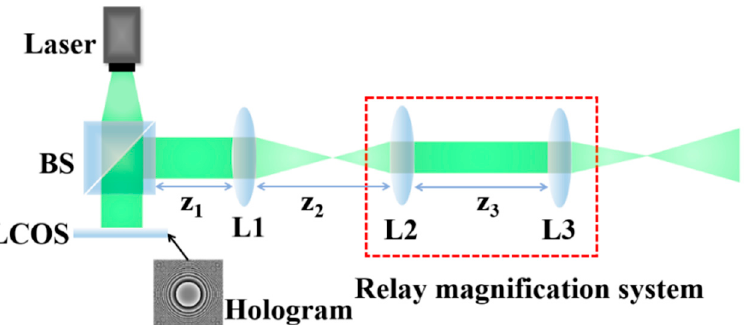
Figure 1. Setup of the optical launching unit.